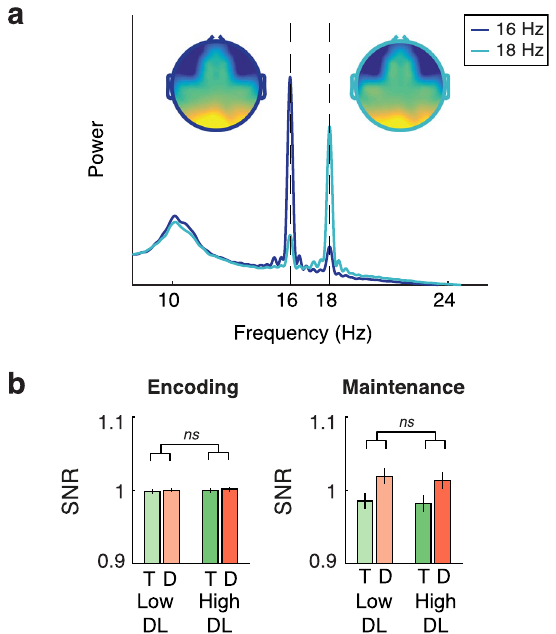
Figure 3. SSVEP responses at the fundamental frequency. ( a ) Frequency spectrum and topography of the RESS time series optimized for 16 (dark blue) and 18 Hz (light blue) activity, computed using the condition- average data in the time-window during which the flickering placeholders were on screen and the SSVEP was stable ( − 500 to 2500 ms; the y-axis reflects arbitrary power units as the RESS time series were computed based on multivariate source separation). At the group level, topographies show strong overlap between frequencies. The frequency spectra confirm distinct differences between the group average RESS time series for 16 and 18 Hz in terms of their frequency content. ( b ) SSVEP response (computed as the normalized SNR) for target (T; green) and distractor (D; red) locations, showing no significant differences in SSVEP power between target and distractor locations. Distractor load (DL; low vs. high; light vs. dark shades respectively) also did not affect SSVEP power. Error bars represent the standard error of the